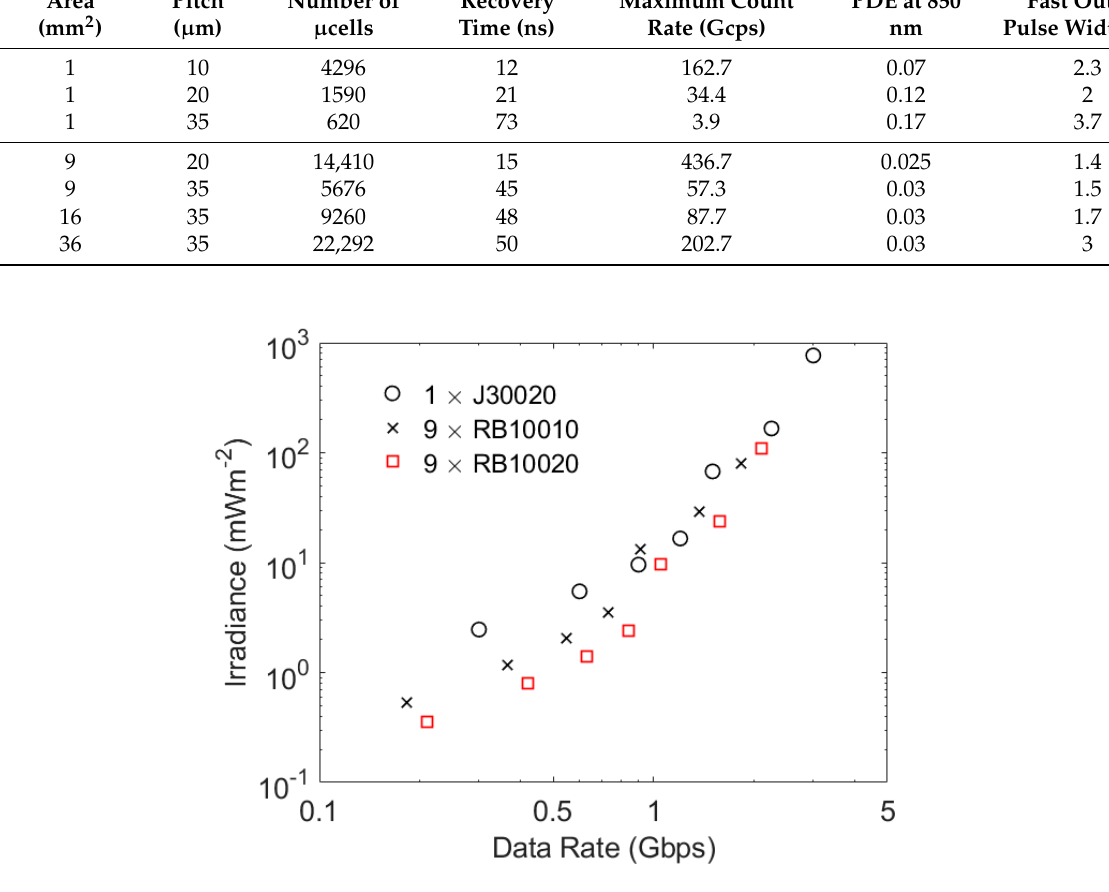
Figure 13. The potential performance of a J30020 and combinations of 9 RB10010 SiPMs and 9 RB10020 SiPMs. These results were obtained using the same methodology as used to obtained the results in Figure 8.